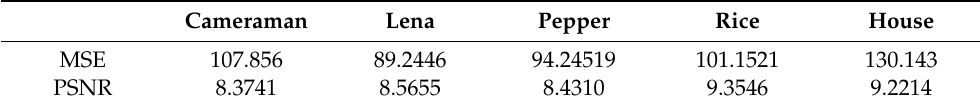
Table 7. Mean squared error (MSE) and peak signal-to-noise ratio (PSNR). Cameraman Lena Pepper Rice House